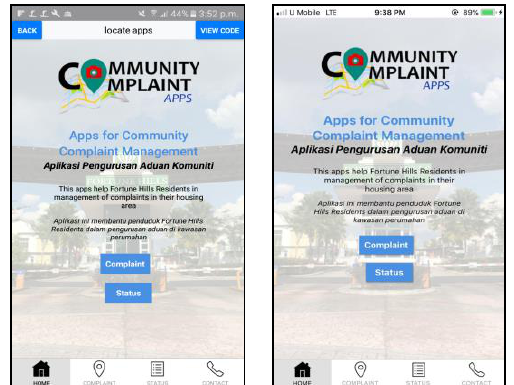
Figure 7. User interface (Android and iOS) of Home